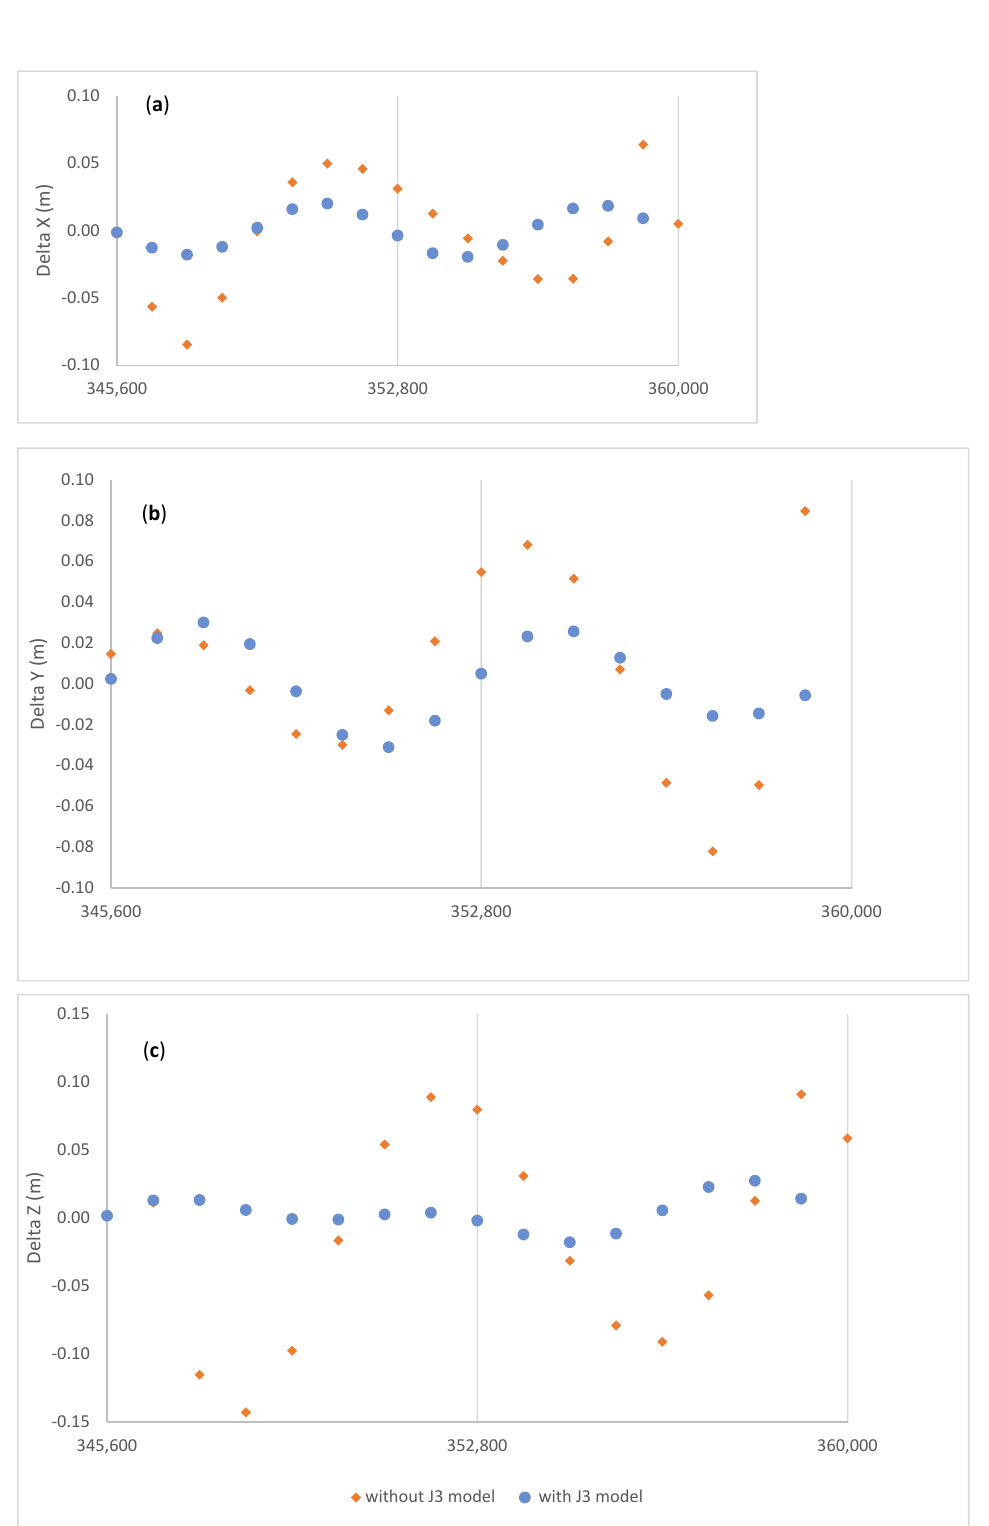
Figure 14. Zoom of the first 4 h of the post-fit residuals of G01 shown in Figure 2 (red diamonds) showing an oscillatory pattern (( a ) X, ( b ) Y, and ( c ) Z). The blue dots represent an attempt to model the oscillation with a signal driven by the third zonal harmonics of the Earth’s gravity field J 3 .